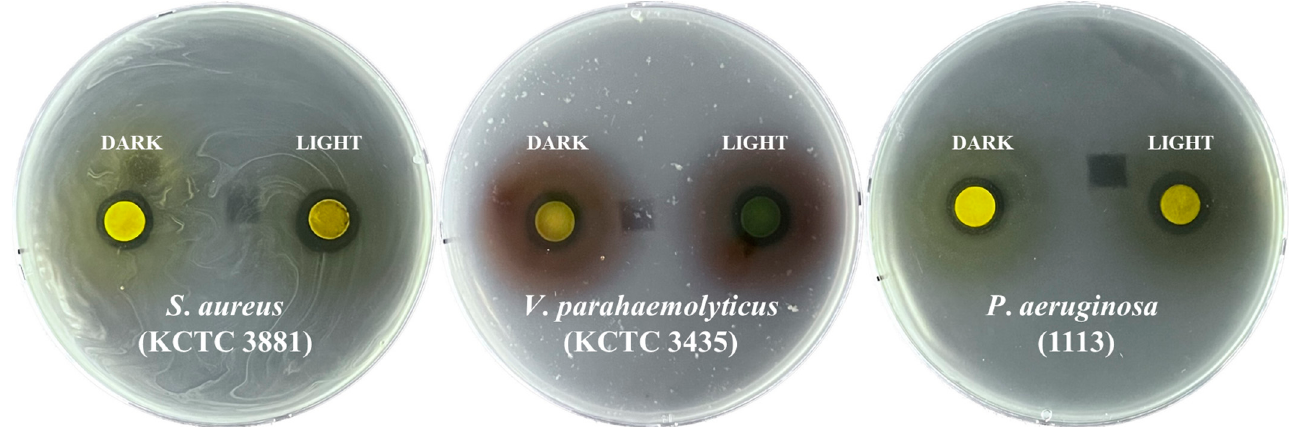
Figure 2. Representative images showing antibacterial activities of methanol extracts of P . frutescens microgreens for 20 days of long-day photoperiod and continuous darkness conditions.